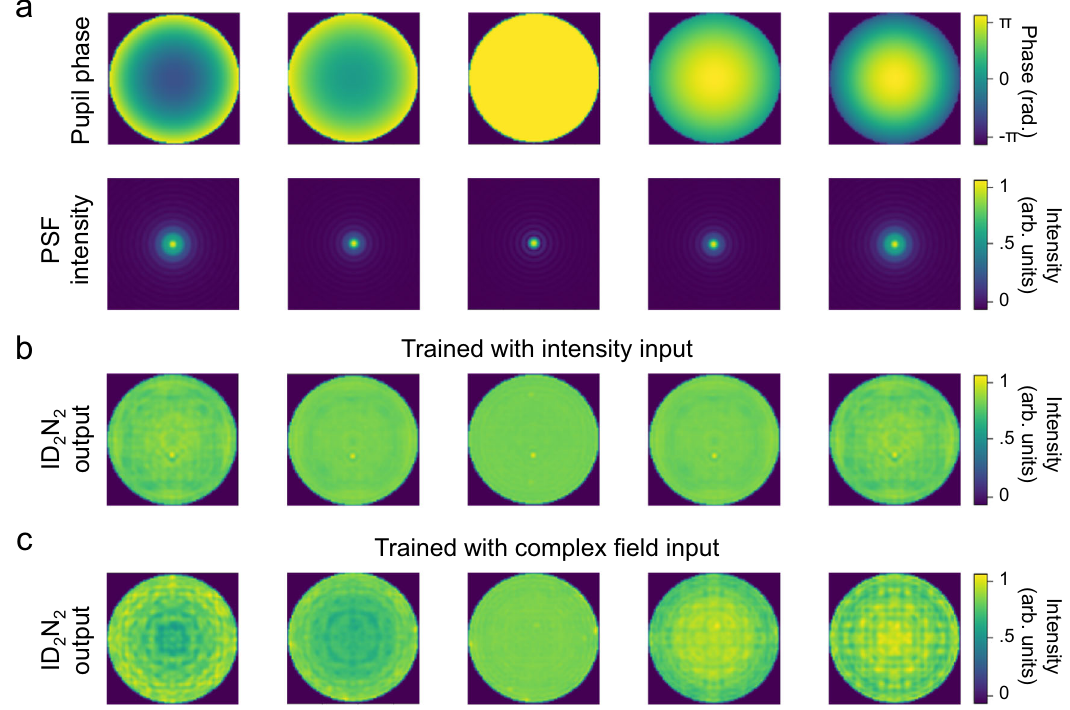
Fig. 2 | ID 2 N 2 non-degenerate response to defocus.a Defocus (Z 4 ) terms applied and corresponding calculated PSF intensities. The amplitude is scanned between ± π radians, the PSF are calculated at the focal spot of a 10× 0.25NA objective for a point source of 100 µ m diameter using a fast focus fi eld method 44 . b Output intensities for the different defocus terms in ( a ) of an ID 2 N 2 trained with PSFs